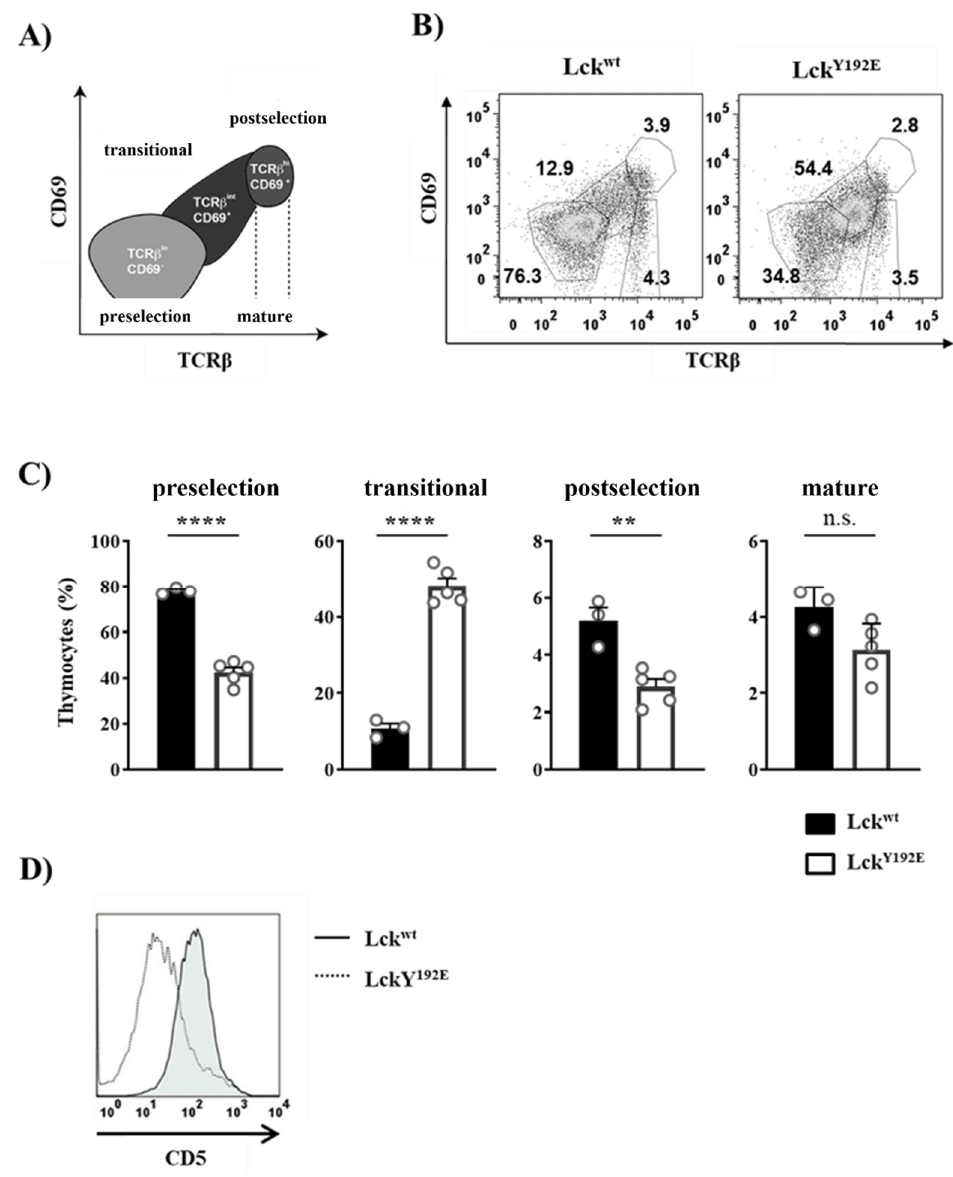
Figure 4. Altered transition of Lck Y192E thymocytes through the developmental stages. ( A ) Schematic representation of developmental stages during thymocyte maturation defined according to TCR β and CD69 expression. Preselection thymocytes were defined as cells expressing low levels of TCR β and no CD69 (TCR β l ◦ CD69 − ), whereas postselection thymocytes were characterized by high levels of TCR β and the expression of CD69 (TCR β hi CD69 + ). Thymocytes expressing intermediate levels of TCR β and CD69 represent a transitional population (TCR β int CD69 + ). Mature thymocytes express high levels of TCR β and low or no CD69 expression. ( B ) Thymocytes were isolated from either Lck wt or Lck Y192E mice and stained with antibodies against TCR β and CD69. Numbers indicate percentages of the cells in each gate. One representative dot plot is shown. ( C ) Bar graphs represent summary statistics of the cell distribution in each developmental stage. Each dot represents one mouse, whereas columns show mean values of all analyzed mice + SEM ( n = 3–5). Statistical analyses were conducted using an unpaired Student’s t test (** p ≤ 0.01, **** p ≤ 0.0001, n .s. = not statistically significant). ( D ) Thymocytes were stained with CD4, CD8, and CD5 antibodies. One representative histogram overlay depicting CD5 expression on DP-gated cells from either Lck wt or Lck Y192E mice ( n = 7) is shown.